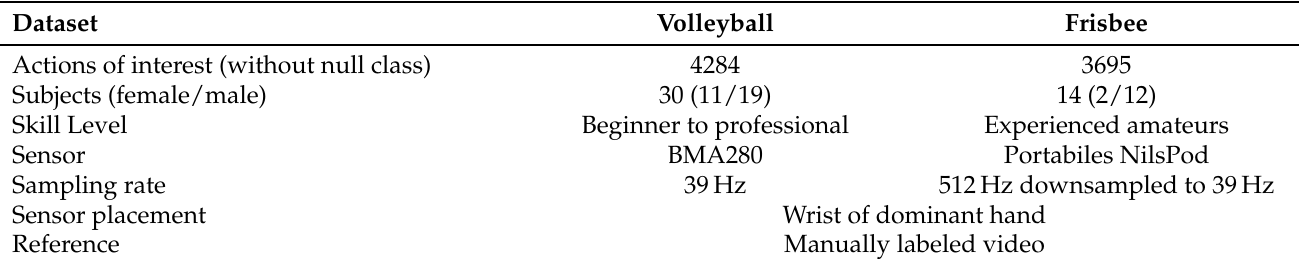
Table 1. Summary of the volleyball and frisbee dataset used in this